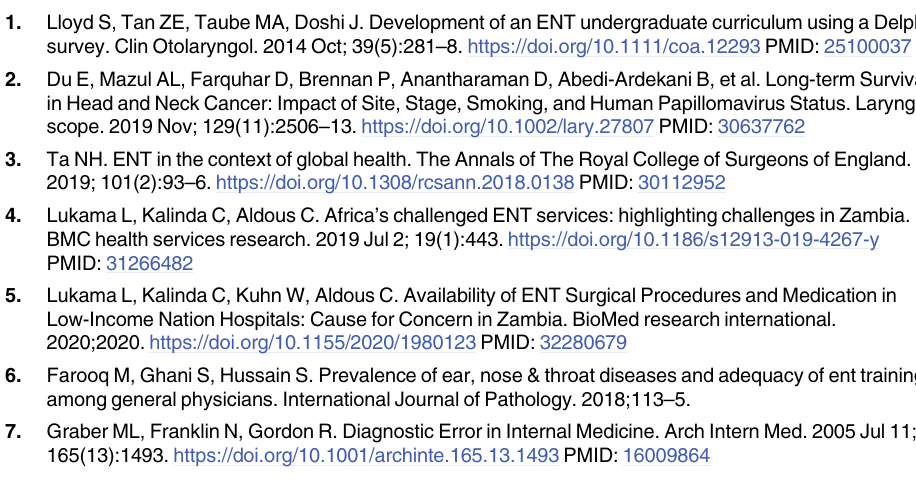
S2 Table. Misdiagnosis across age groups, ENT subspecialties, referral facilities level of care and provinces. S3 Table. Appropriateness of referral across age groups, ENT subspecialties, referral facili- ties level of care and